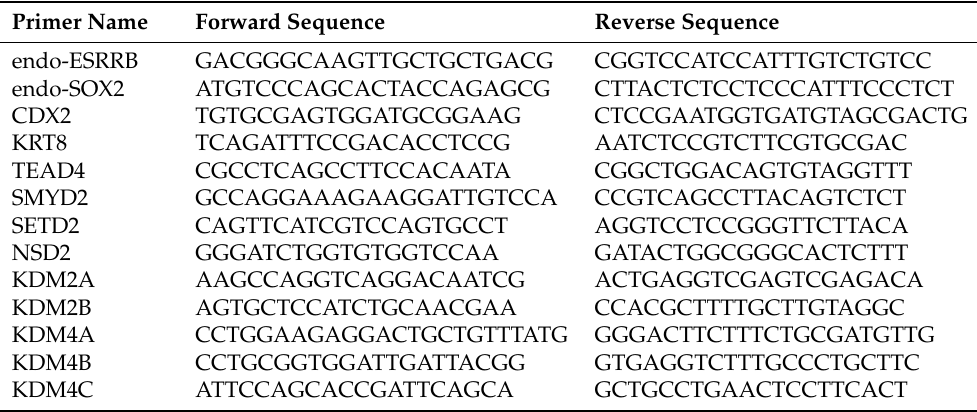
Table 1. The primers used in this